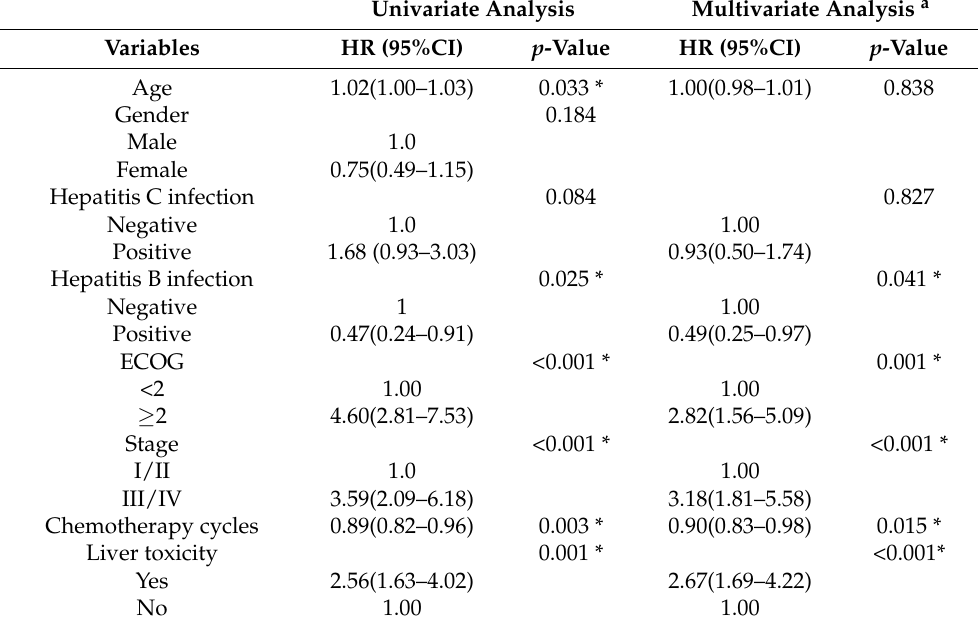
Table 4. Univariate and multivariate analysis of risk factors for progression-free survival. Univariate Analysis Multivariate Analysis